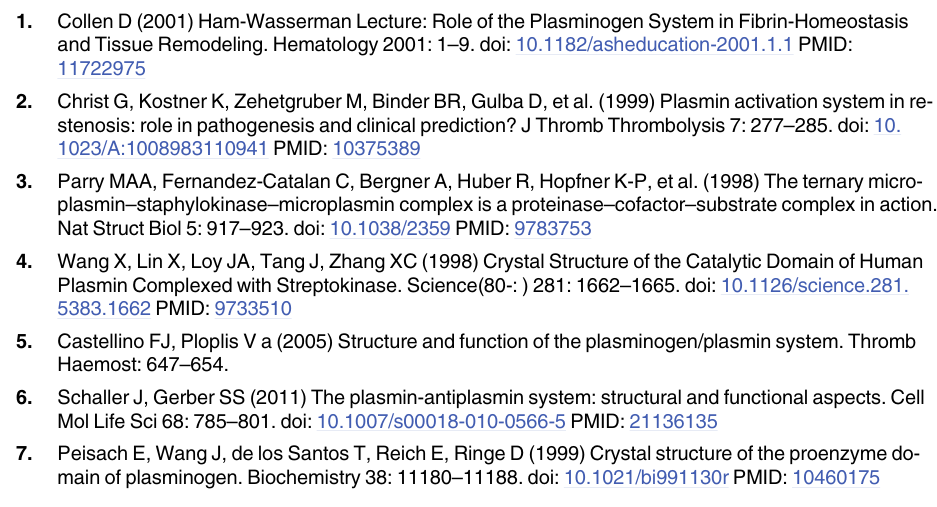
S1 Table. Characteristics of the disulphide bonds in human plasminogen. The solvent- accessible surface area (ASA) of the cysteine residues, classification and the protein domain are described for each of the disulphide bonds of the full-length native human